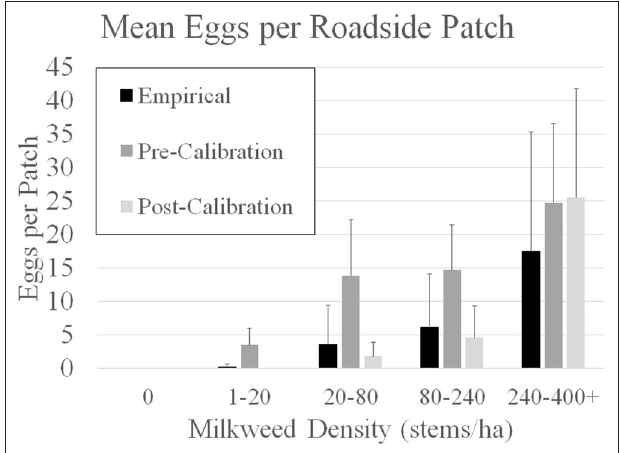
FIGURE 3 | Comparison of model-predicted mean eggs per 50m X 50m patch in five categories of milkweed density in two 1.6km roadsides in Boone and Story counties in Iowa, USA. Empirical data from Blader (2018). Pre- calibration estimates for the roadsides is based on the agent-based model assumptions in Grant et al. (2018). Post-calibration estimates are derived from the Grant et al. (2018) model after calibration with empirical milkweed density provided in Blader (2018). Error bars are 1